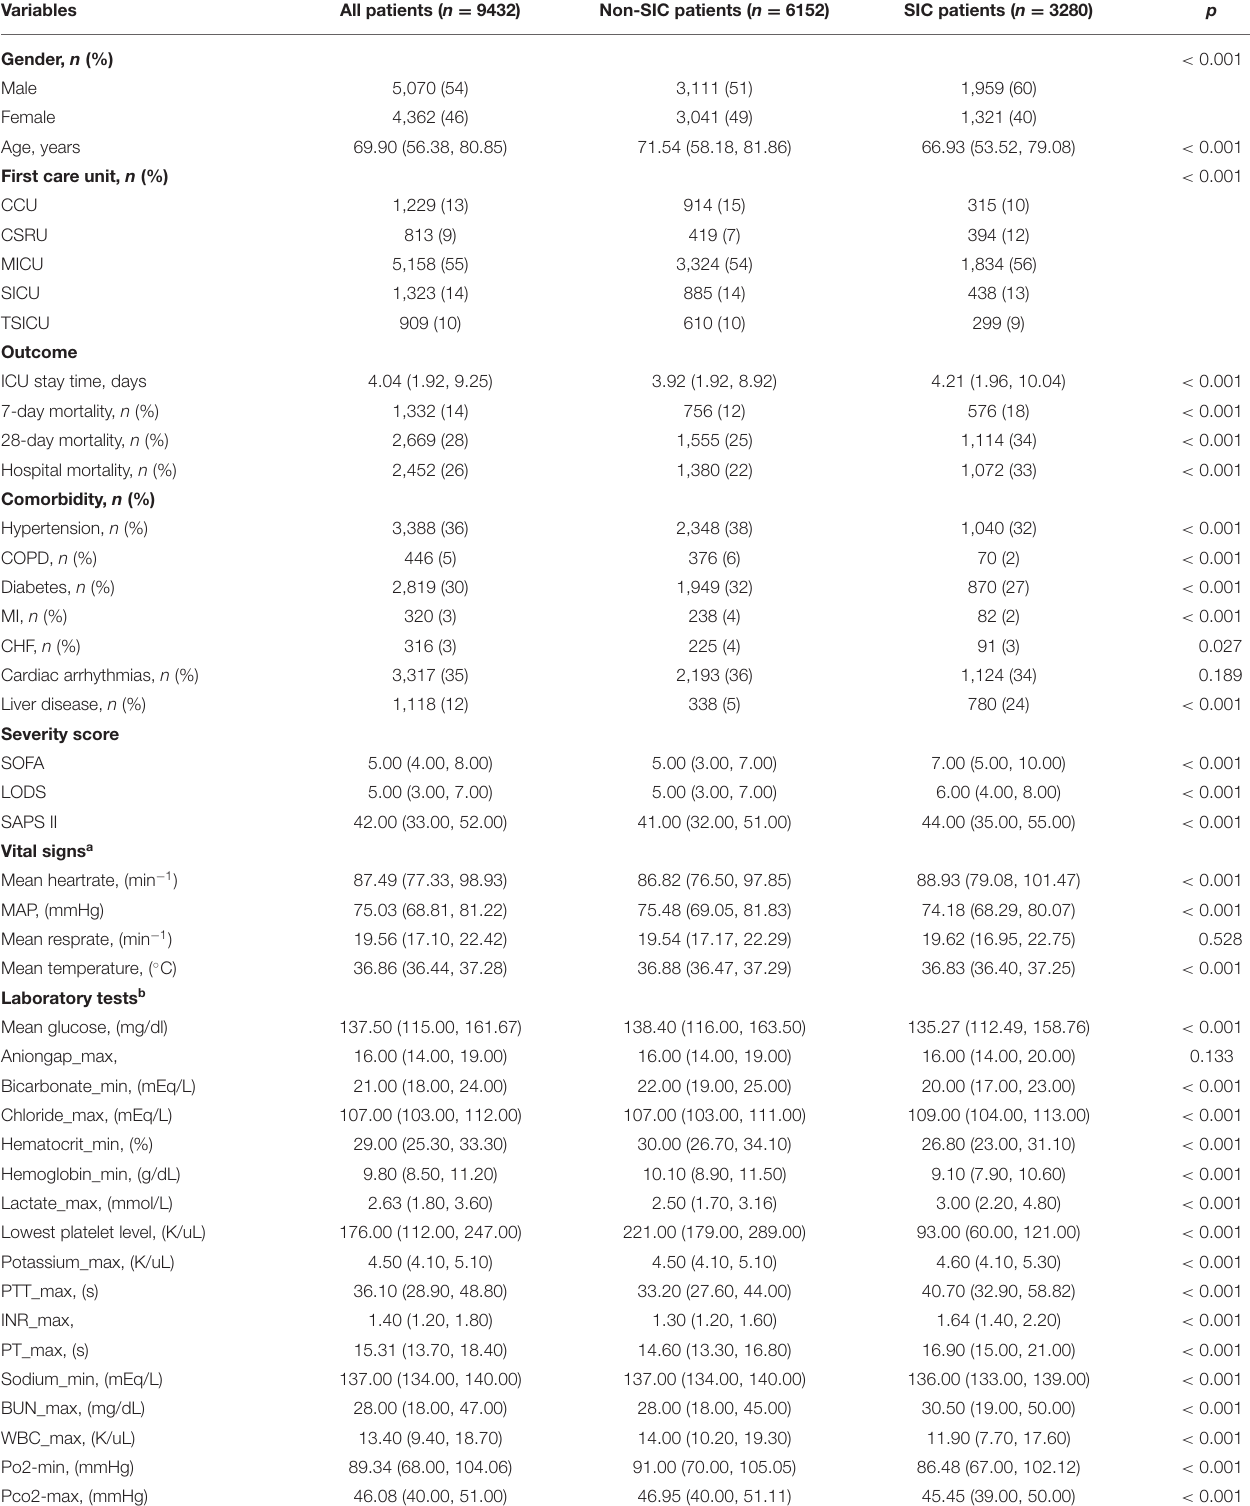
TABLE 1 | The characteristics of included patients when first ICU admission. Variables All patients ( n =